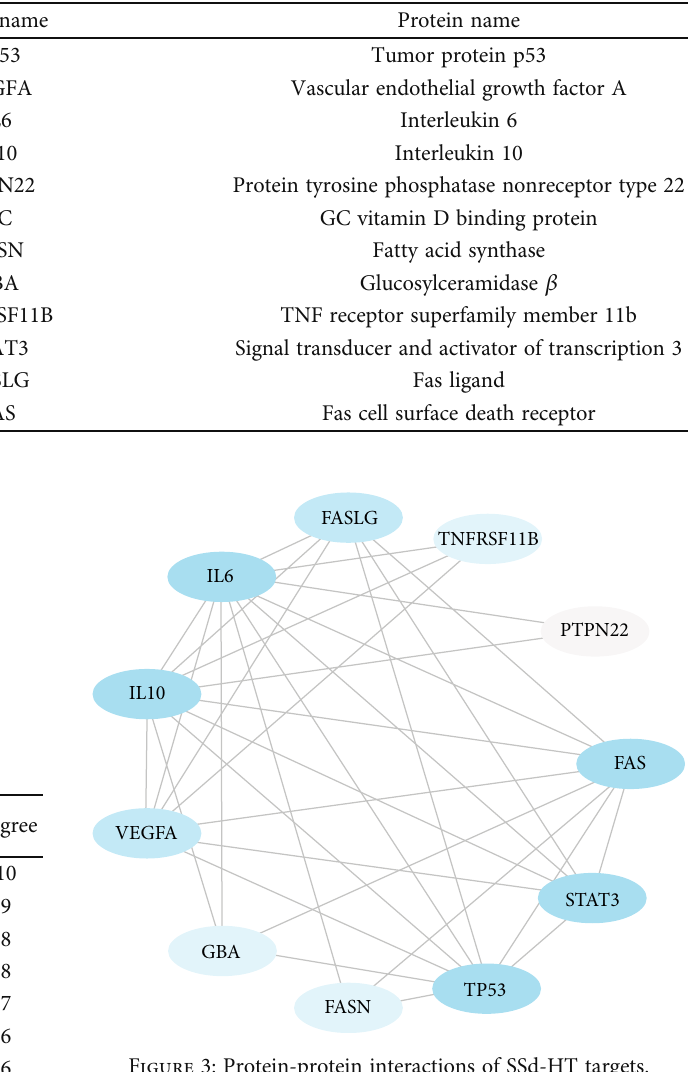
Table 3: Intersection of SSd and HT targets.